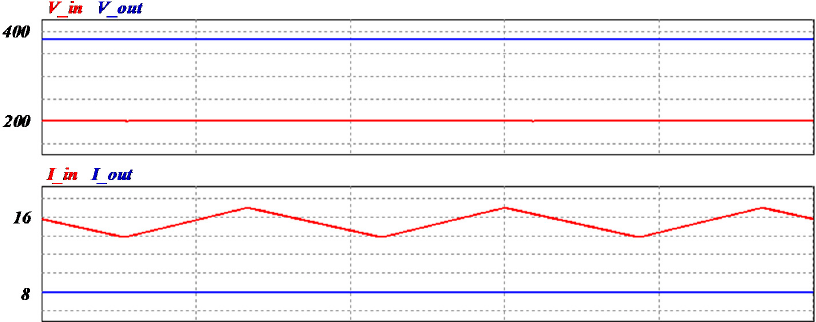
Figure 16. ( a ) Waveforms of voltage and current of each switch and ( b ) expansion waveforms.